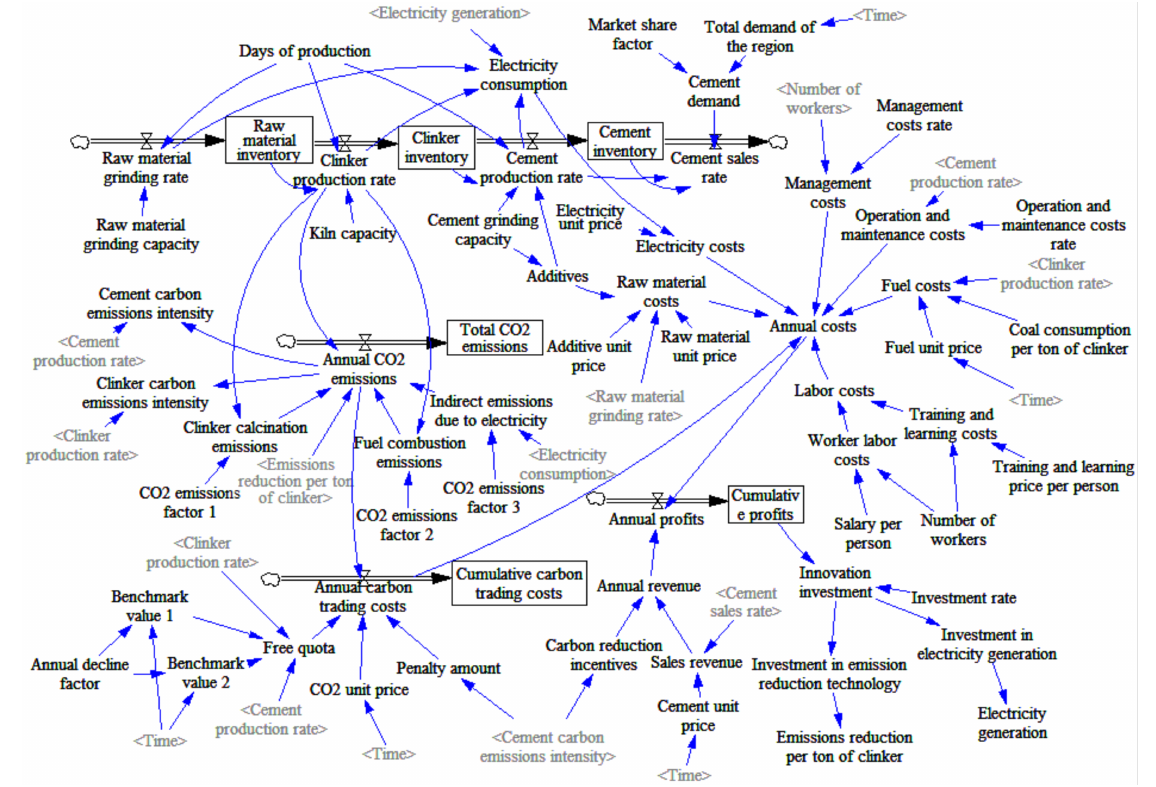
Figure 4. Stock flow diagram of the system dynamics